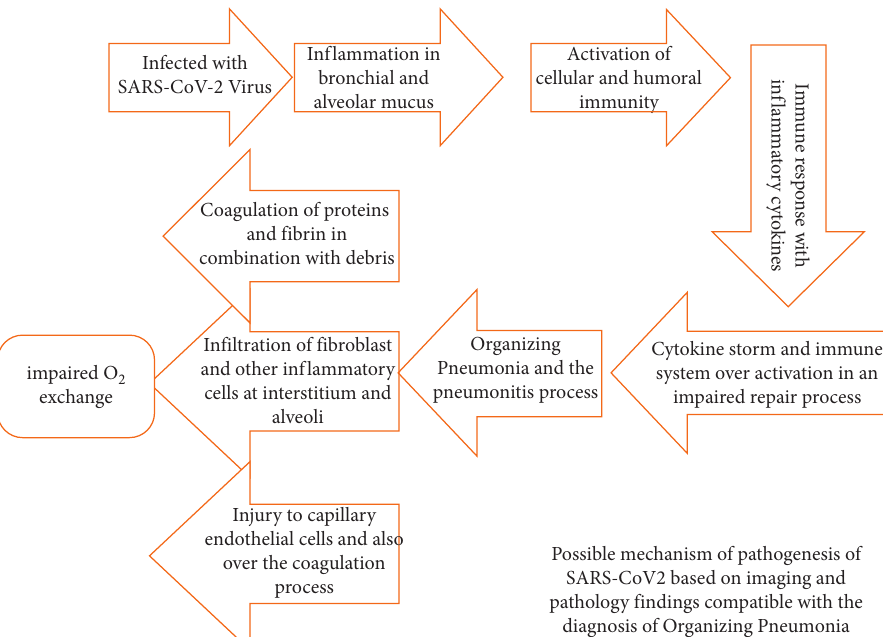
Figure 9: Diagram illustrating the main pathophysiological steps of COVID-19-related lung infection and damage (inflammatory and fibrotic).